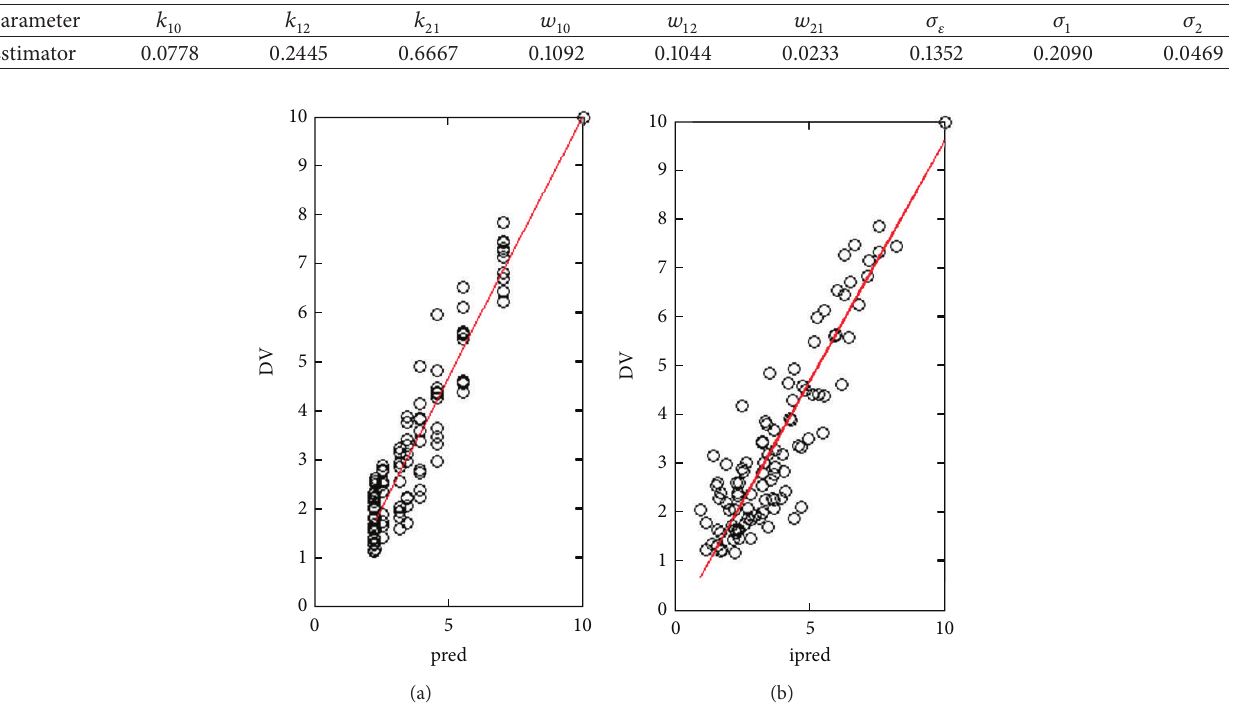
Figure 2: Basic goodness-of-fit graph for simulated data. (a) Plot of observed versus population predicted value and (b) observed versus individual predicted value. The solid lines are the lines of identity.